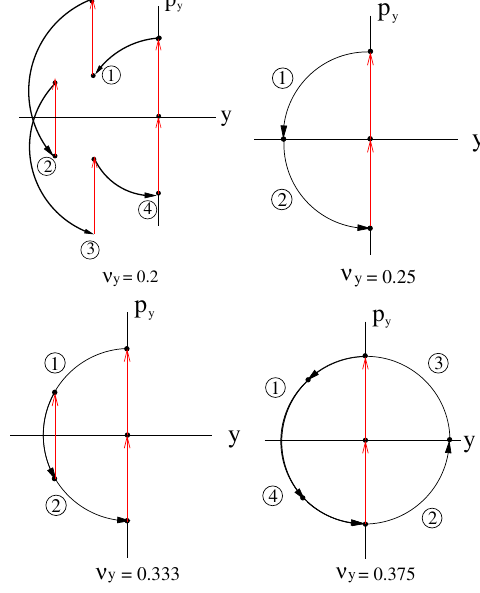
FIG. 1. Illustration of KAC schemes in a normalized phase space at different